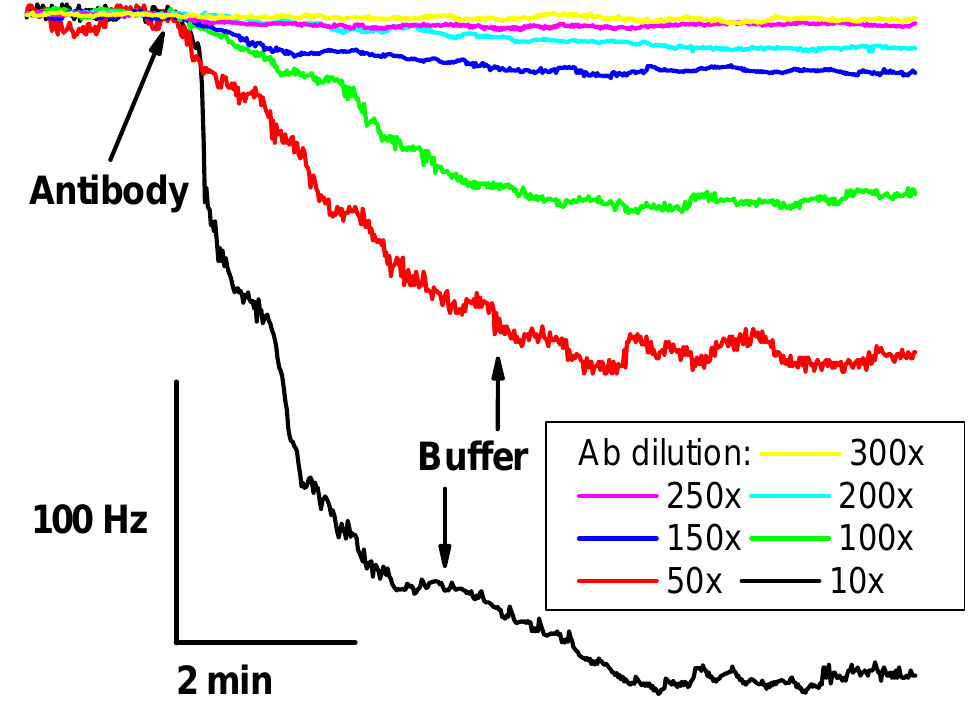
Fig. 5. The influence of the mAb 4H3B9D3 dilution (indicated inside the figure) on the binding response obtained with the piezoelectric sensor modified with the LPS from F. tularensis . The sample volume was 100